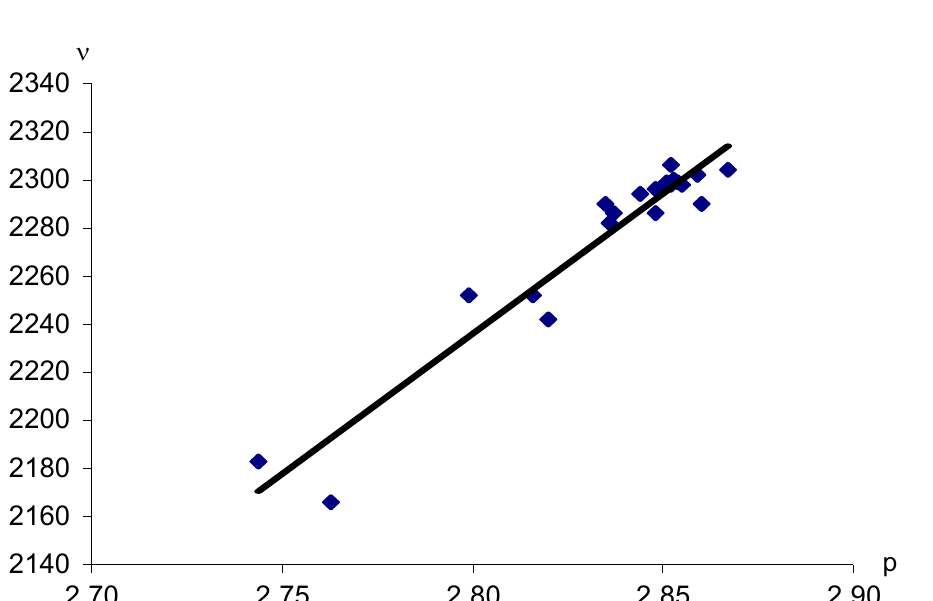
Figure 2. Dependence of stretching vibrational frequencies ( ν , cm − 1 ) (in vaseline oil) for fragment C-N + ≡ N bonds in aryldiazonium XC 3-CH , 4-CH , 4-COCH 3 3 , 4-NO , 4-OH, 3-OCH 3-NO 2 2 r =